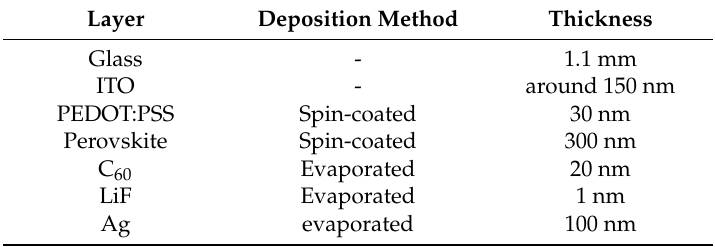
Table 5. Layer deposition technique and thickness of different layers in the optimized solar cell